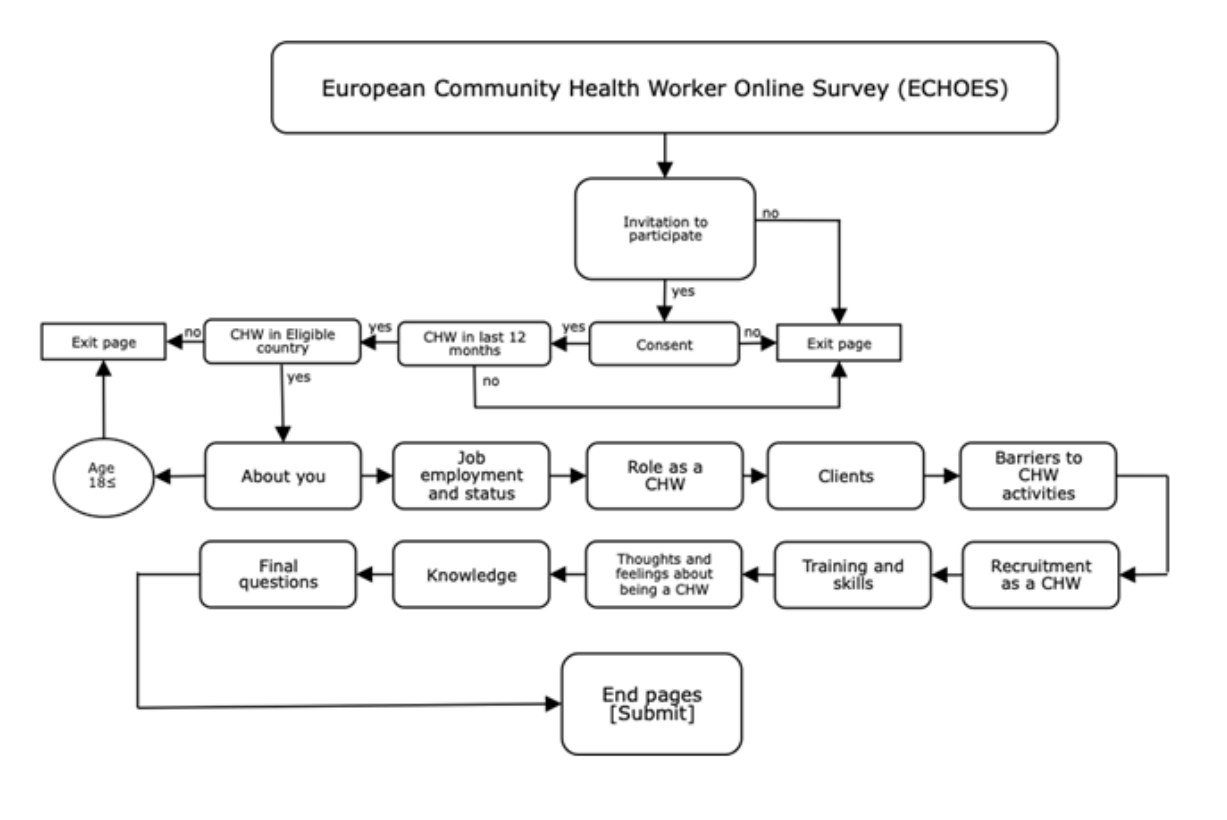
Figure 2. Flow diagram of ECHOES questionnaire